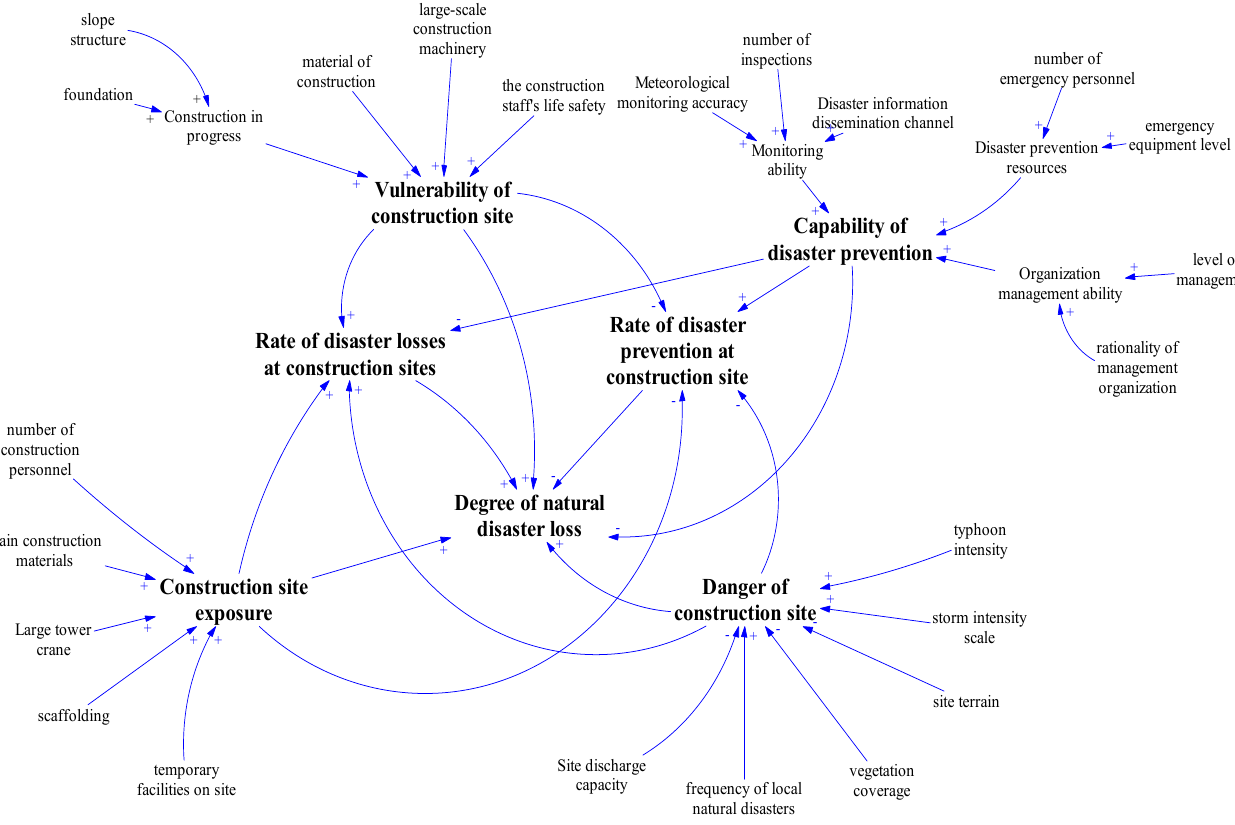
Figure 2. Causal analysis of construction site systems under typhoon.